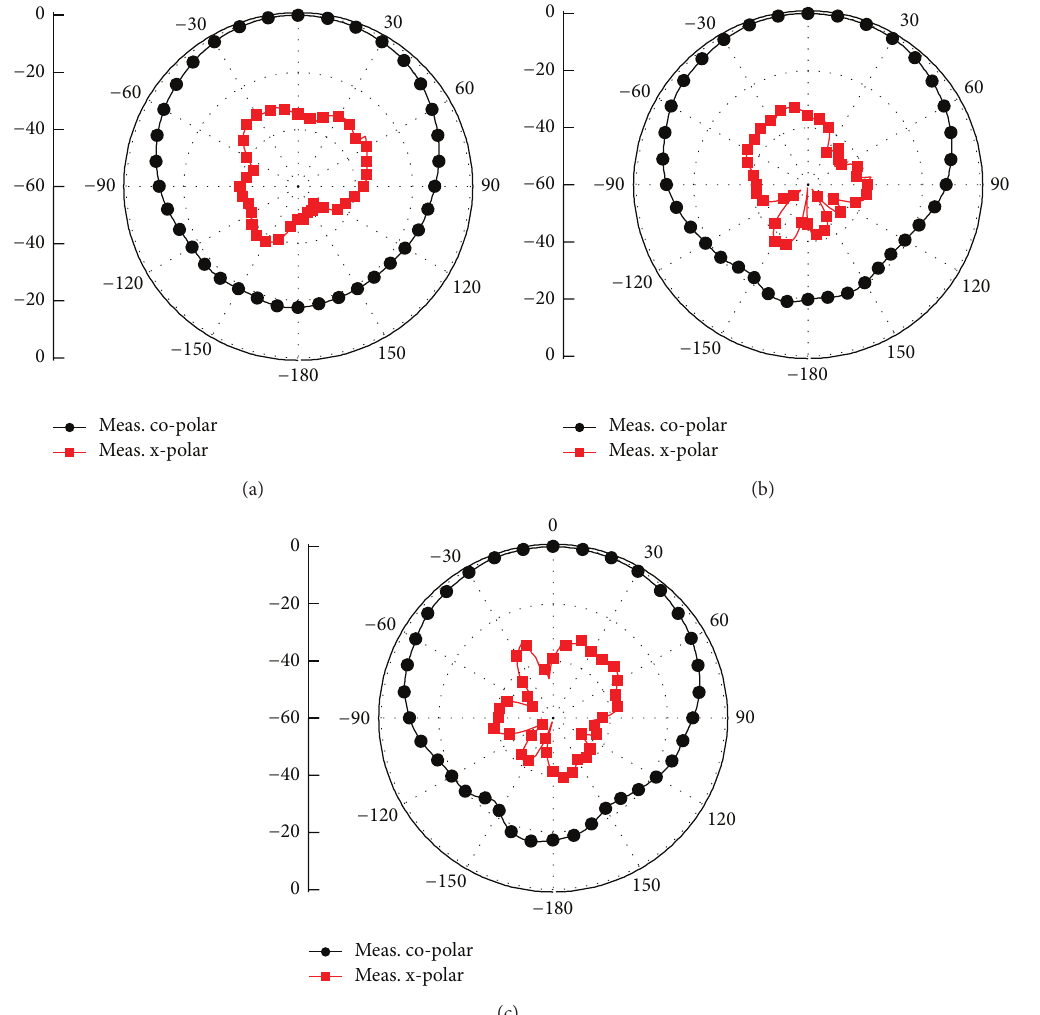
Figure 9: Measured radiation patterns for H-plane (yoz plane) at (a) 2.5 GHz, (b) 3 GHz, and (c) 3.5 GHz for Port 1.